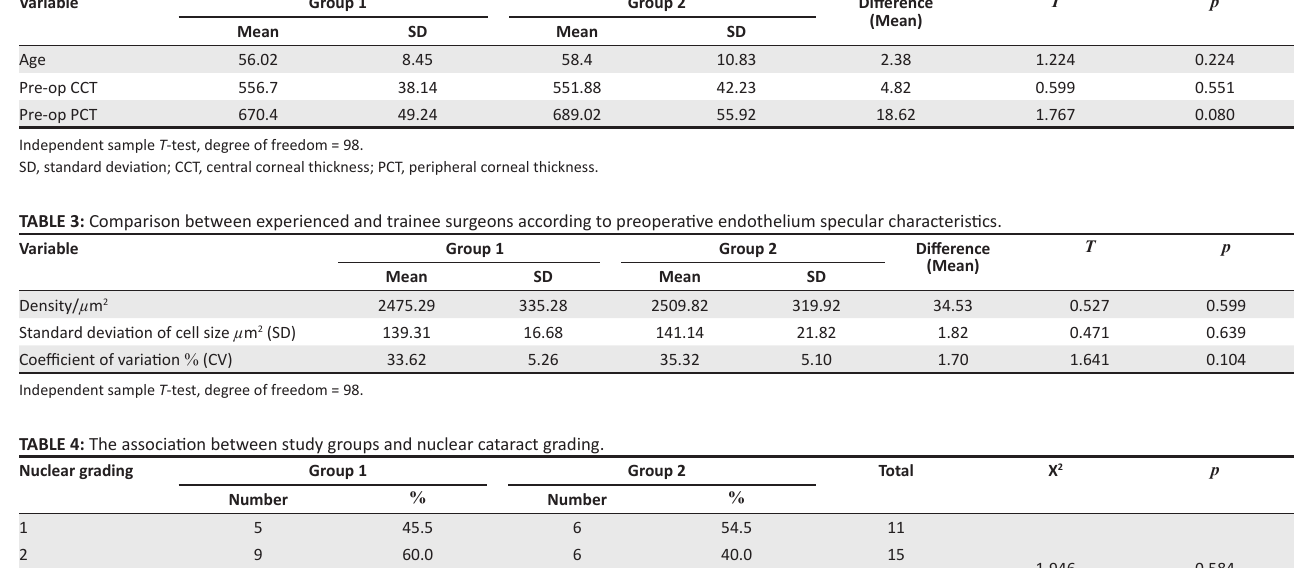
TABLE 2: Comparison between experienced and trainee surgeons according to age, preoperative central and peripheral corneal thickness. Variable